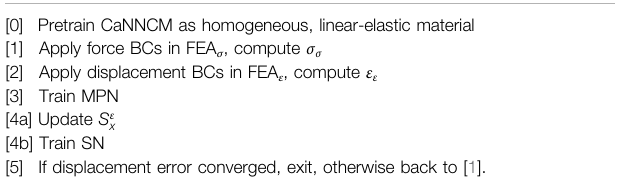
Algorithm 3 | AutoP Training of